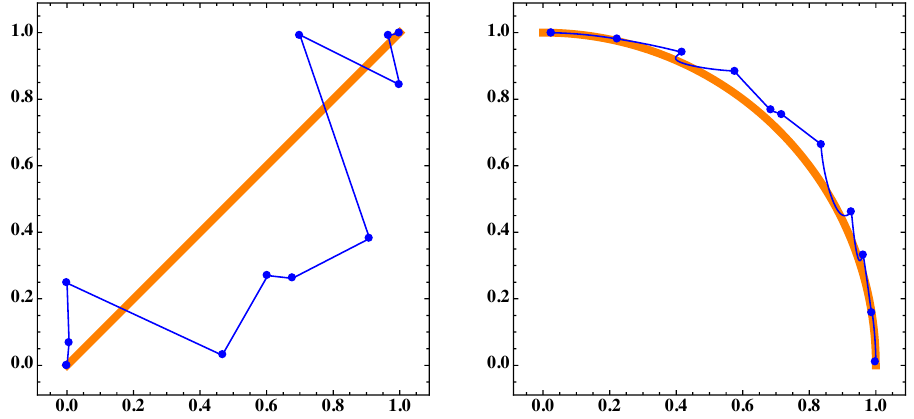
Figure 19. The same as in Figure 18 but for γ =